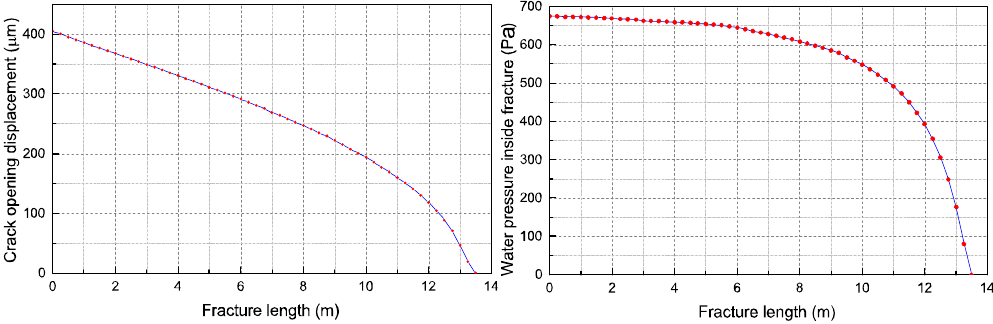
Figure 16. The crack mouth opening displacement ( left ) and the water pressure distribution along the crack ( right ).